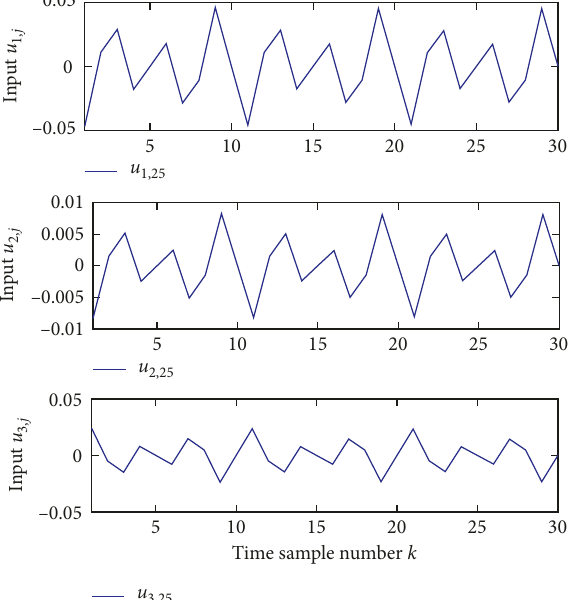
Figure 4: Evolutions of all inputs with trial length n